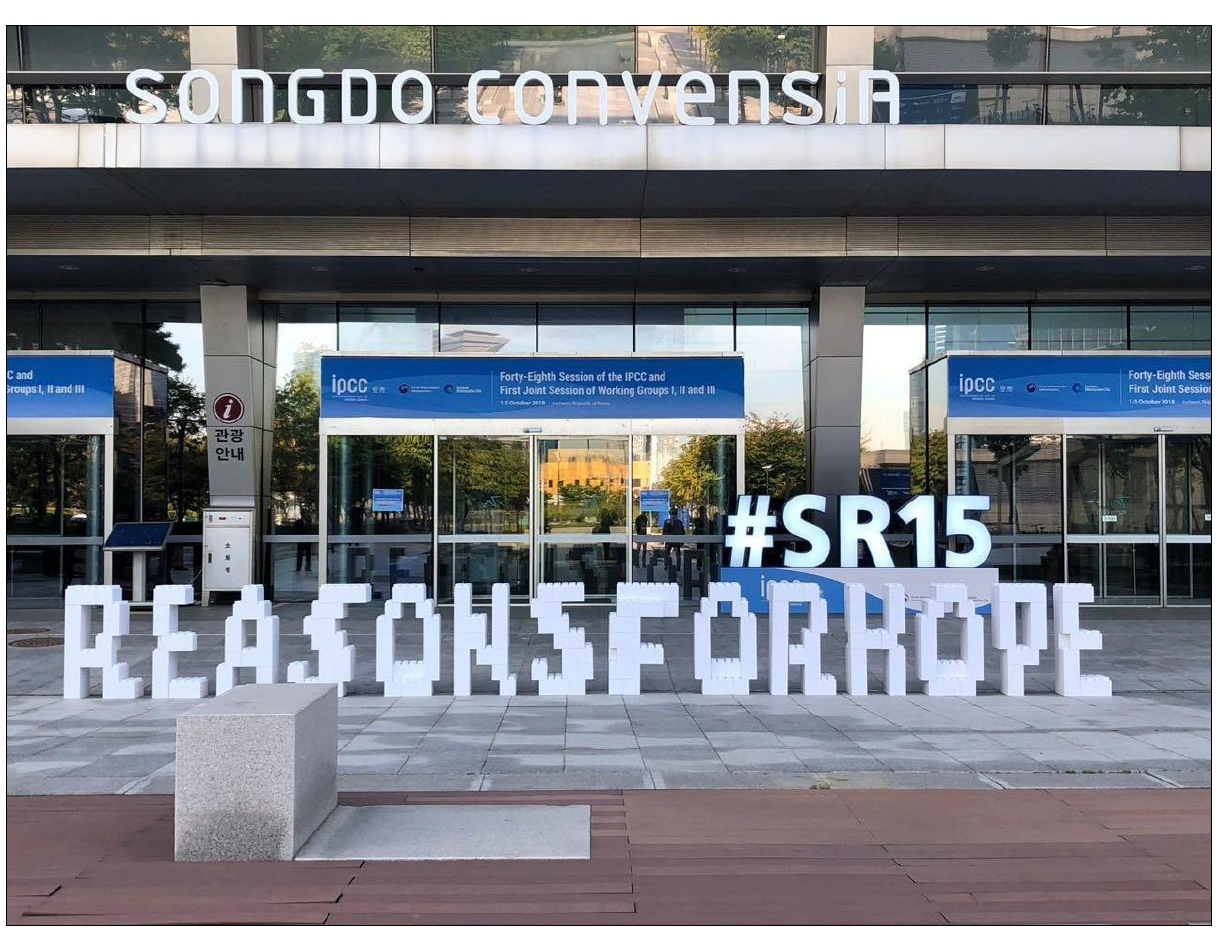
Figure 5: The IPCC Special Report on Global Warming of 1.5 °C was released under the banner of ‘Reasons for Hope’ in October 2020, indicating that strong climate action could still restrict global warming to below 1.5 °C. In 2021, that hope has